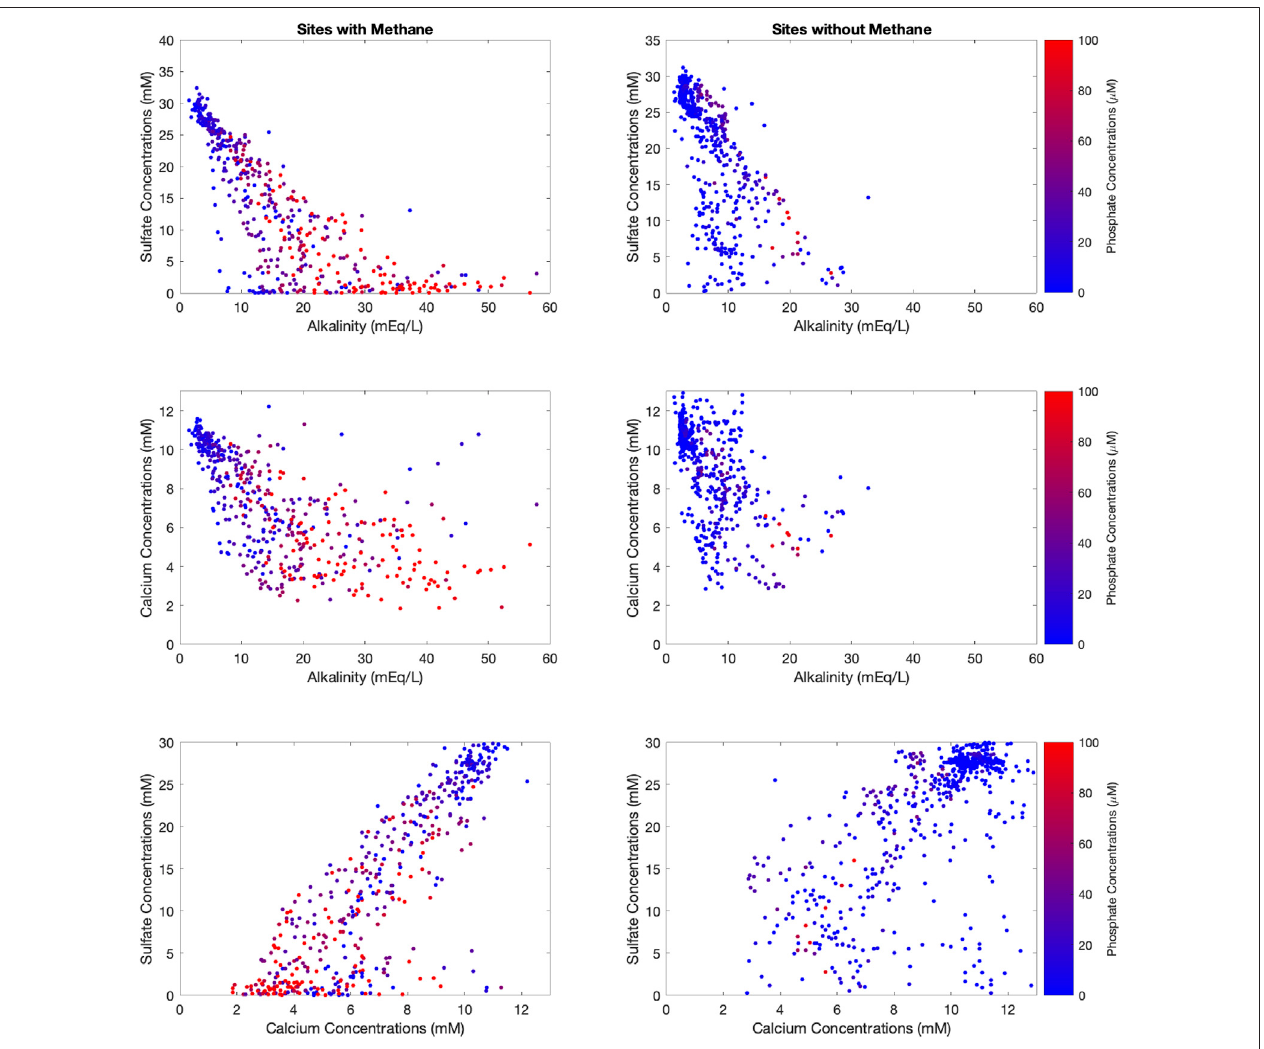
FIGURE3| Crossplotsofsulfatevs.alkalinity (toprow) ,calciumvs.alkalinity (middlerow) andsulfatevs.calcium (bottomrow) withthedatacolor-codedbythe concentration of pore fl uid phosphate. The data are split into sites that have methane (left column) vs. sites that do not (right column) .